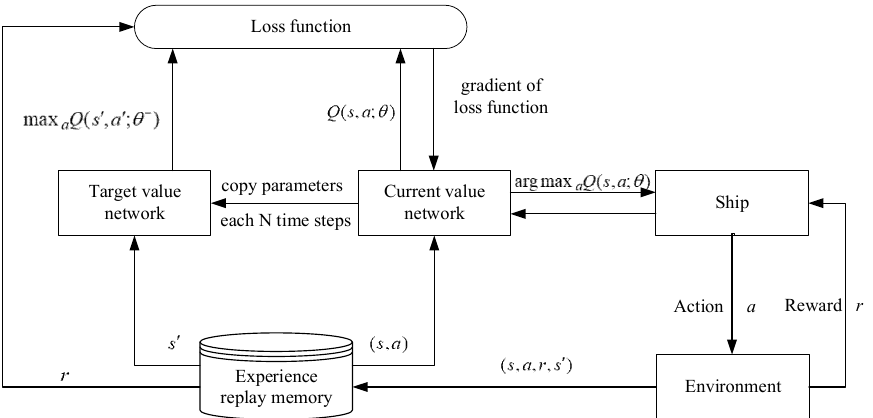
Figure 6. Schematic diagram of coastal ship path planning based on optimization deep Q network (DQN) algorithm.